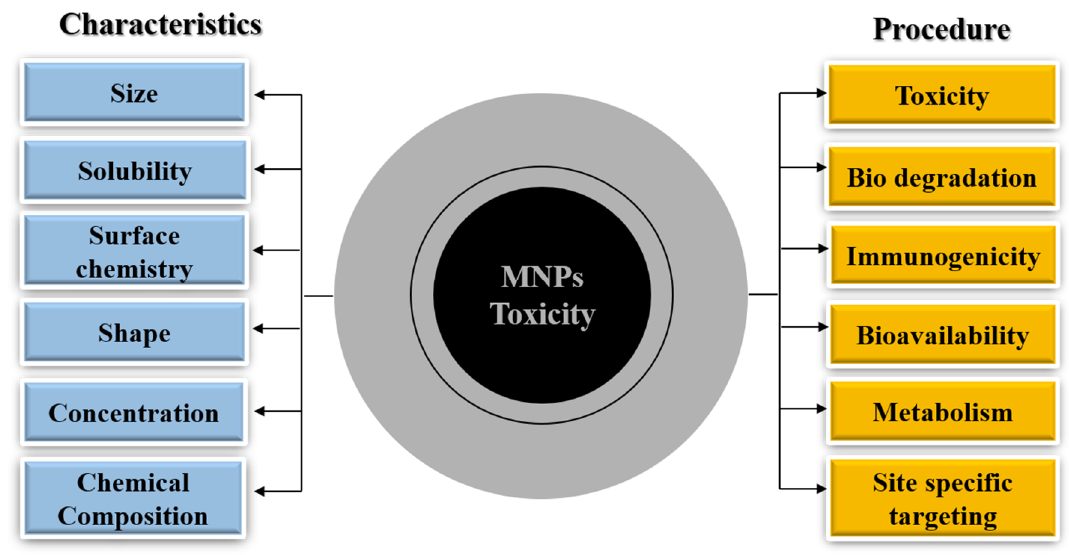
Figure 1. Characteristic properties of magnetic nanoparticles (MNPs). Physical properties like particle size, solubility, surface chemistry, shape, concentration, and chemical composition, determined at a broad scale to analyze subsequent toxicity caused by them in cell lines (normal / contaminated) and model organisms are summarized in the left panel (highlighted by blue color). The procedures to observe the underlying mechanism of toxicity, immunogenicity, metabolism, bioavailability and biodegradation under different parameters for designing MNPs more specifically for biomedical applications safely are summarized in the right panel (highlighted in orange color). See the Table 1 summary for detailed literature citations.